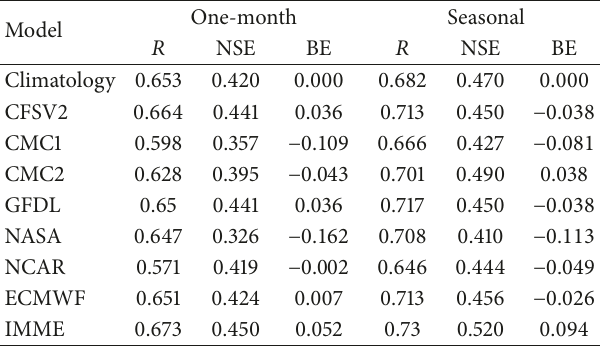
Table 6: Models’ results in respect to the observed climatology quantified by the Benchmark Efficiency (BE) , Northern Israel, Latitude: 33.0, Longitude: